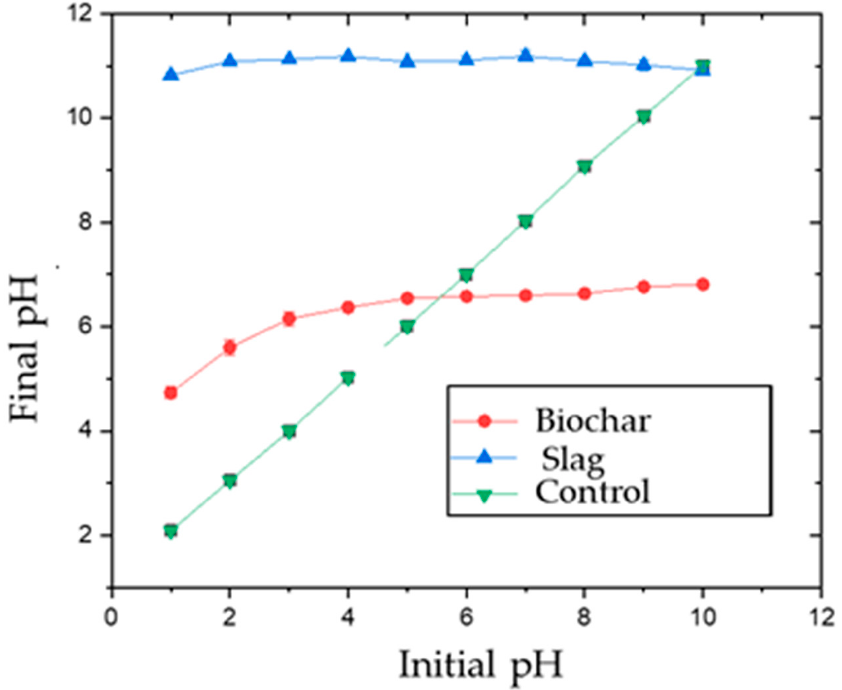
Figure 2. Point of zero charges (PZC) for biochar and slag [adsorbent concentration = 1.0 g/L; shaking time 24 h].